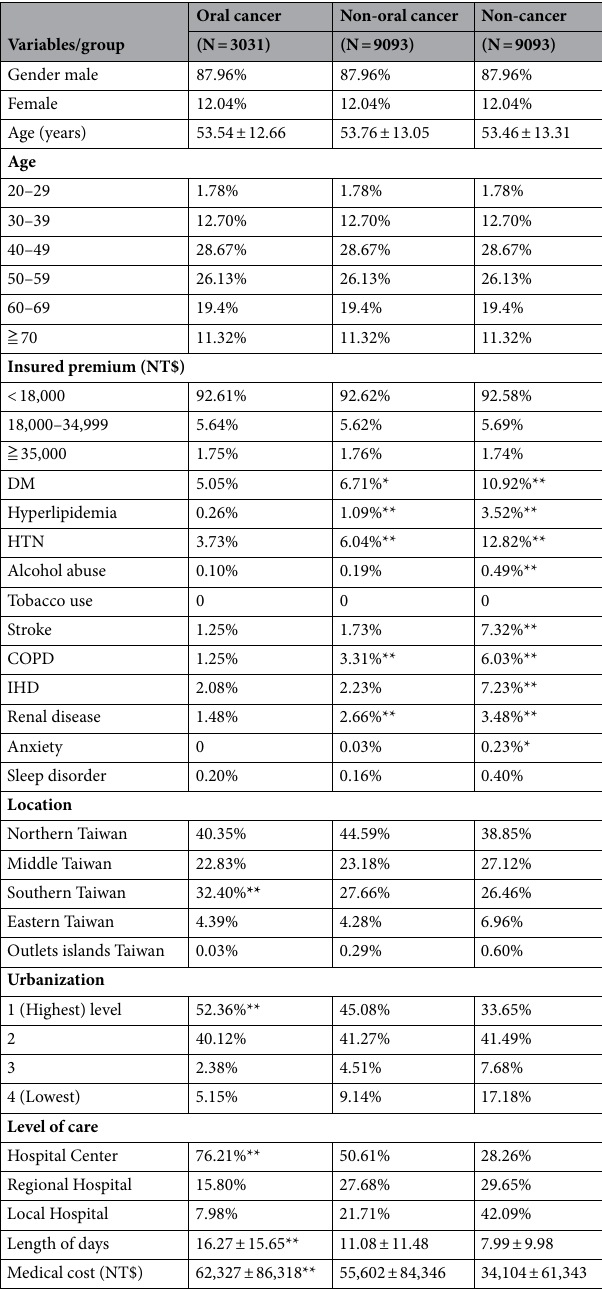
Table 1. Characteristics of study in the baseline. Significant values are in bold. P: Chi-square/Fisher exact test on category variables and t-test on continue variables. NT$ New Taiwan Dollars, DM diabetes mellitus, HTN hypertension, COPD chronic obstructive pulmonary disease, IHD ischemic heart disease. *The pair of subsets showed a significant difference at p < 0.05. **The pair of subsets showed a significant difference at p <